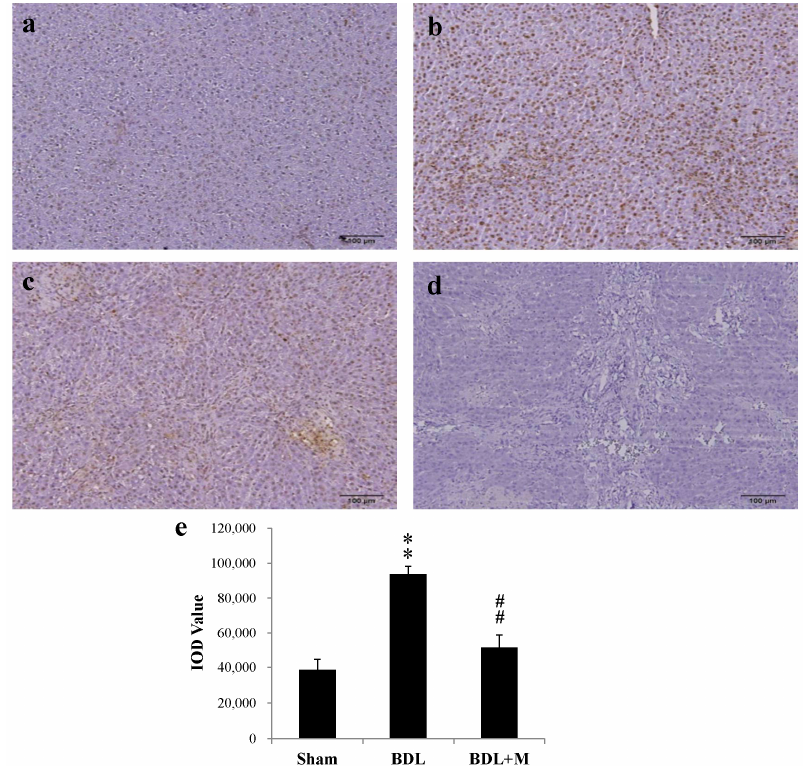
Figure 1. Representative Terminal deoxynucleotidyl transferase dUTP nick end labeling